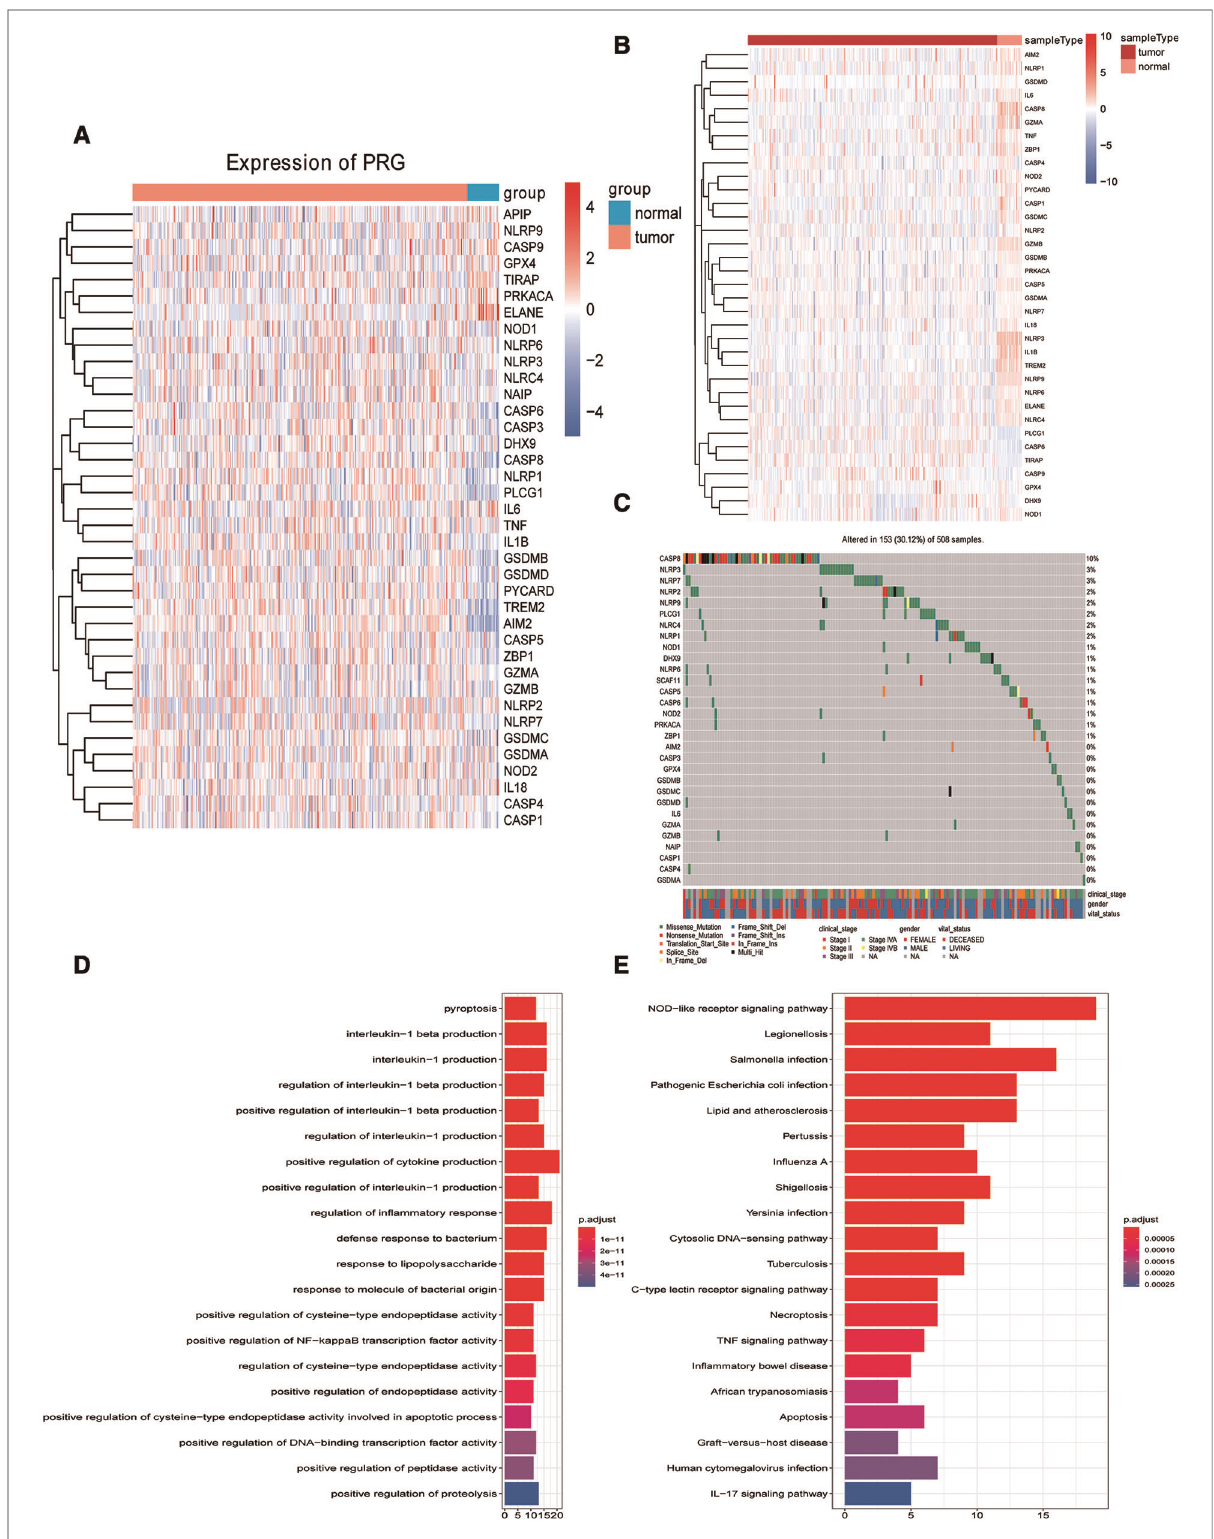
FIGURE 2 Evaluation of pyroptosis genes in Oral squamous cell carcinoma. Expression heat map ( A ), methylation heat map ( B ), and top 30 mutant waterfall diagrams ( C ) of 42 pyroptosis-related genes in the training dataset. Gene Ontology analysis ( D ) and Kyoto Encyclopedia of Genes and Genomes pathway enrichment analysis ( E ) using 42 pyroptosis-related genes in the training